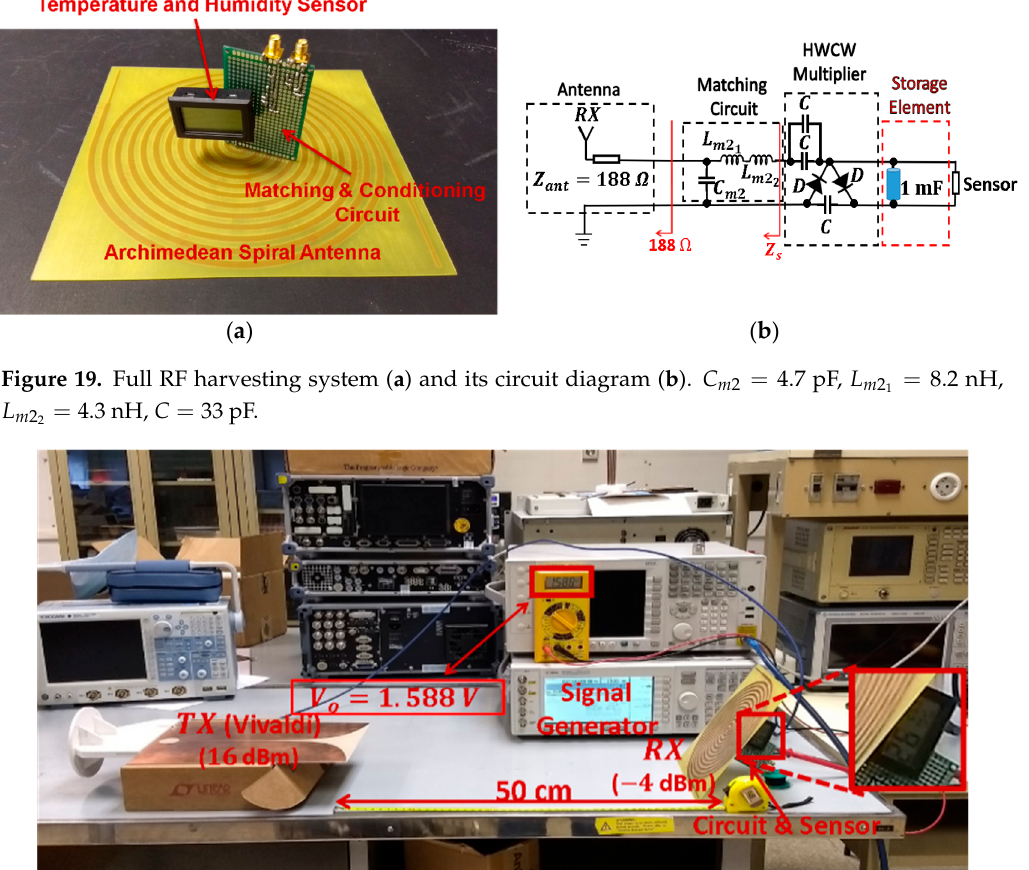
Figure 20. Full-system validation: receiving RF energy harvesting system (on the right) in front of a transmitting Vivaldi antenna (on the left).